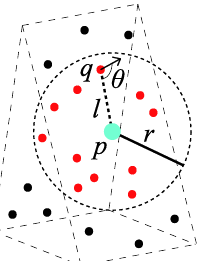
Figure 1. Overview of our proposed method